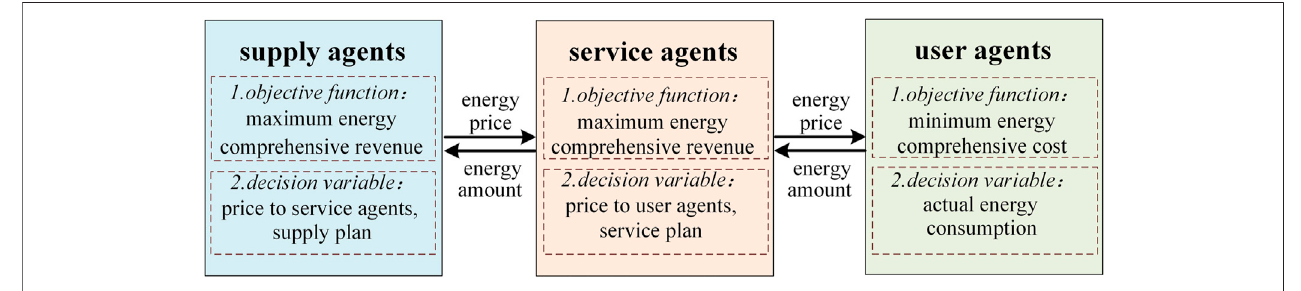
FIGURE 5 | Multi-agent game relationship